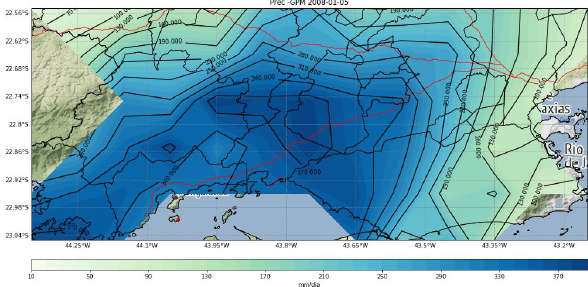
Algorithm (GPROF2017), interleaved with the combined radar algorithm and GPM Ku radiometer, and fused in half an hour